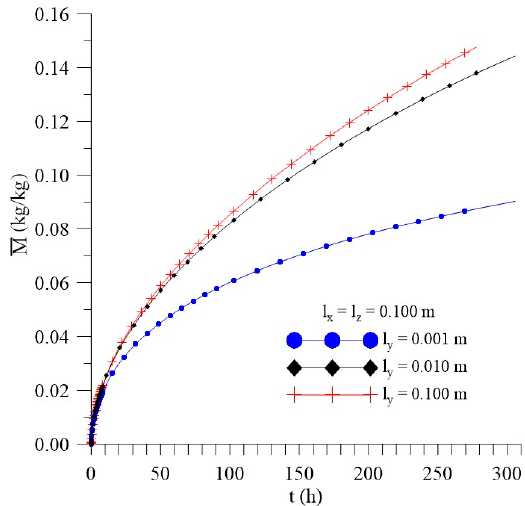
Figure 23. Kinetics of the average moisture content for different l y (Cases 9, 11, and 12).